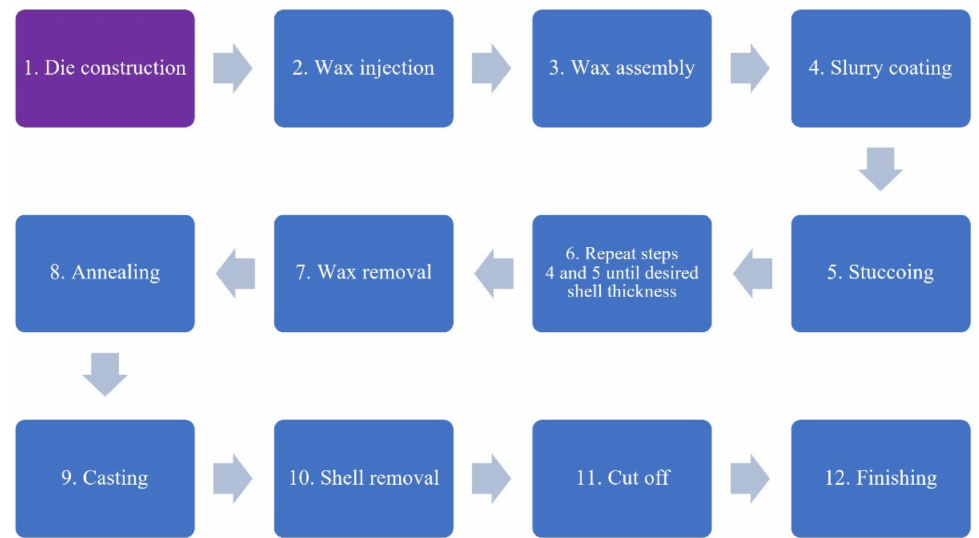
Figure 1. Schematic view of the investment casting process with the analyzed production stage marked with purple